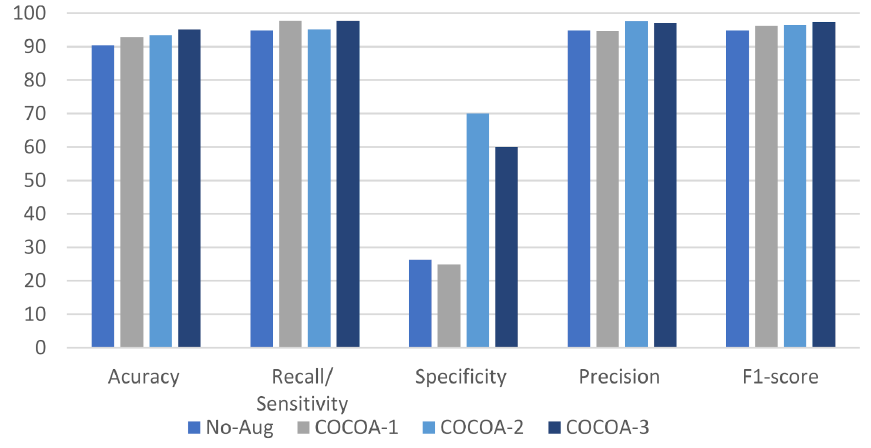
Figure 10. Comparison of metrics for classification of Healthy vs. Recovered Full (Mel-spectrogram images).